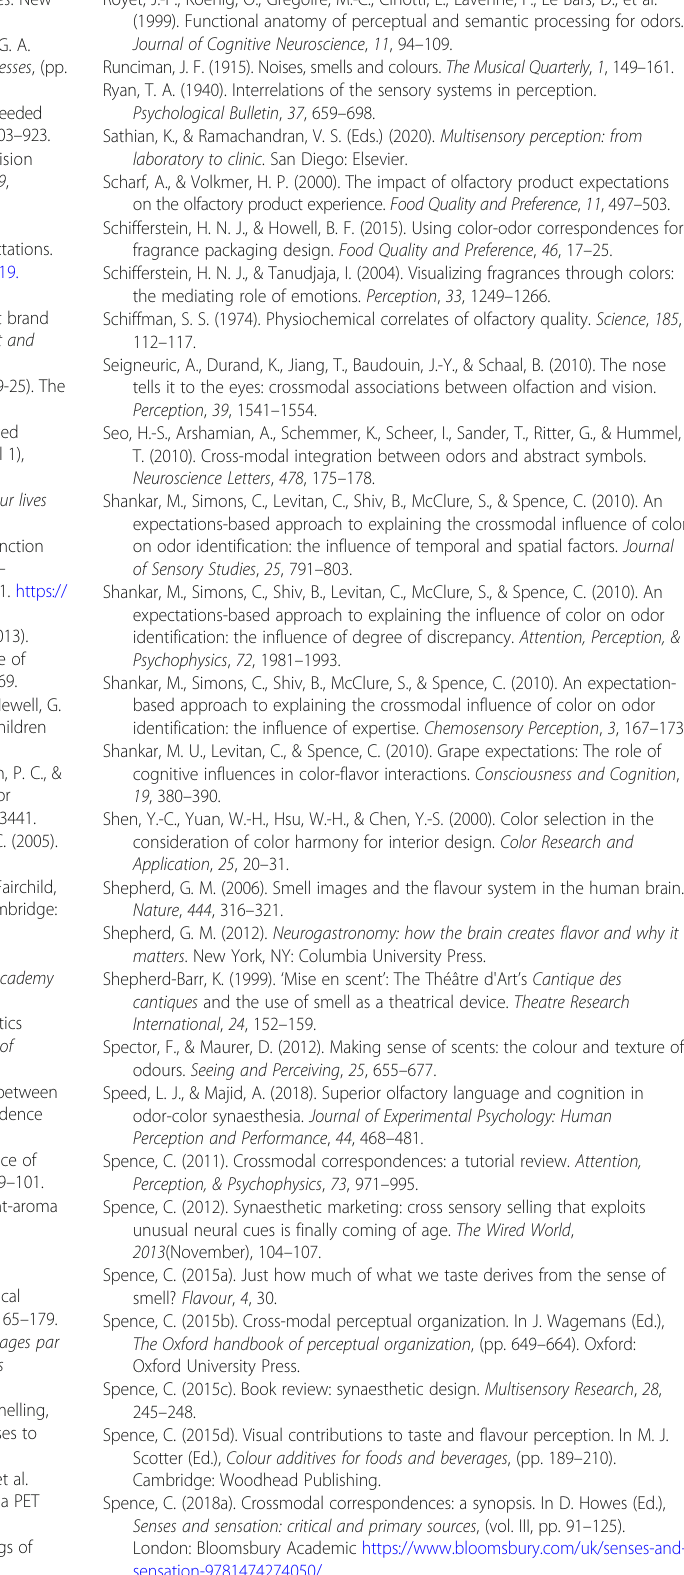
Marks, L. (1978). The unity of the senses: Interrelations among the modalities . New York: Academic Press. Marks, L. E. (2004). Cross-modal interactions in speeded classification. In G. A. Calvert, C. Spence, & B. E. Stein (Eds.), Handbook of multisensory processes ,